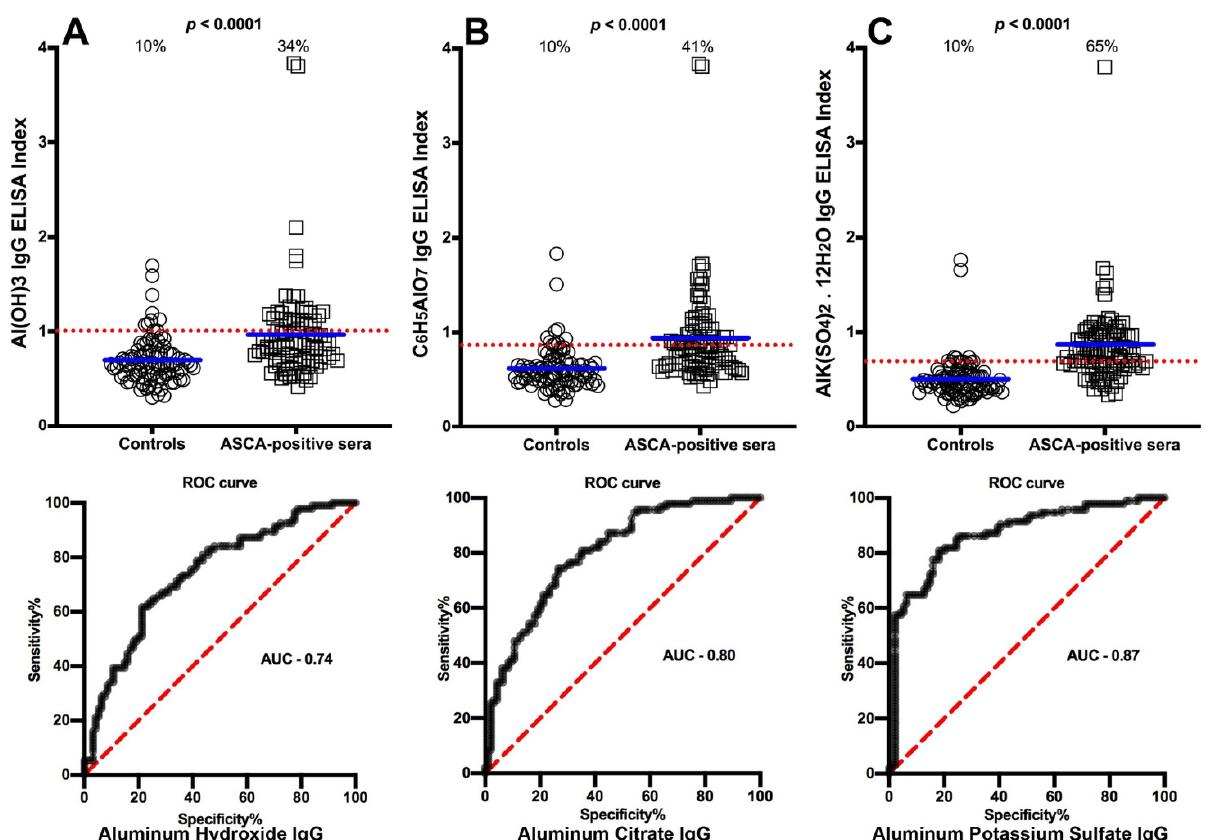
Figure 1. Percentages of samples with elevations in IgG antibodies against three different aluminum compounds in 94 healthy controls and 47 patients positive for ASCA (Crohn’s disease). Dotted horizontal lines indicate the cutoff for positivity used in each assay, as calculated by receiver operating characteristic (ROC) analysis. The percentages of elevation, controls vs. patients, are indicated at the top of each distribution, while the thick short horizontal full bars indicate the respective means ( A ) The percentage of ASCA-positive patients with elevated IgG antibodies against aluminum hydroxide was 34%, with an area under the curve (AUC) of 0.74; ( B ) The percentage of ASCA-positive patients with elevated IgG antibodies against aluminum citrate was 41%, with an AUC of 0.80; ( C ) The percentage of ASCA-positive patients with elevated IgG antibodies against aluminum potassium sulfate was 65%, with an AUC of 0.87.